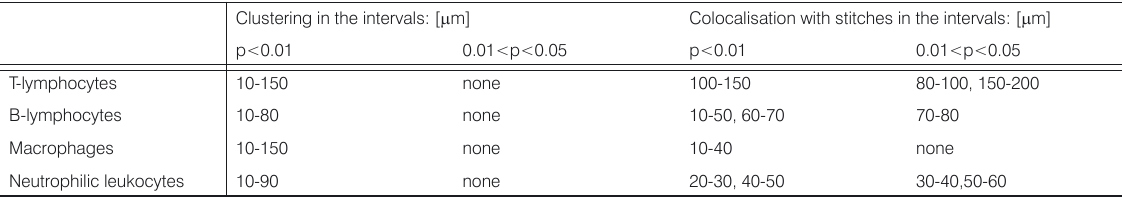
Table 2. Spatial distribution of leukocytes within the transplanted aortic